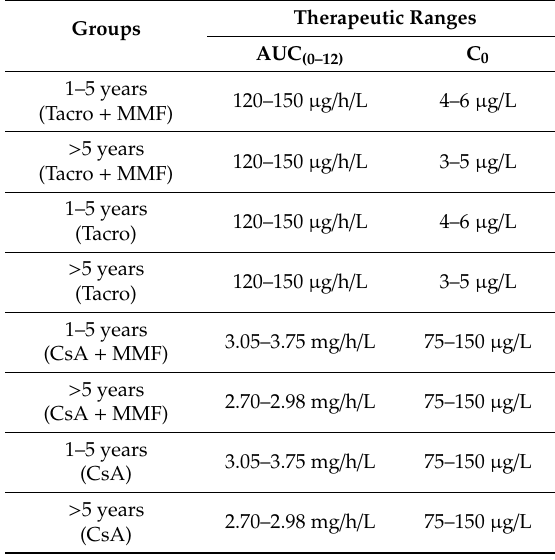
Table 1. Therapeutic ranges of AUC (0–12) and C 0 for kidney recipients receiving tacrolimus or cyclosporine.